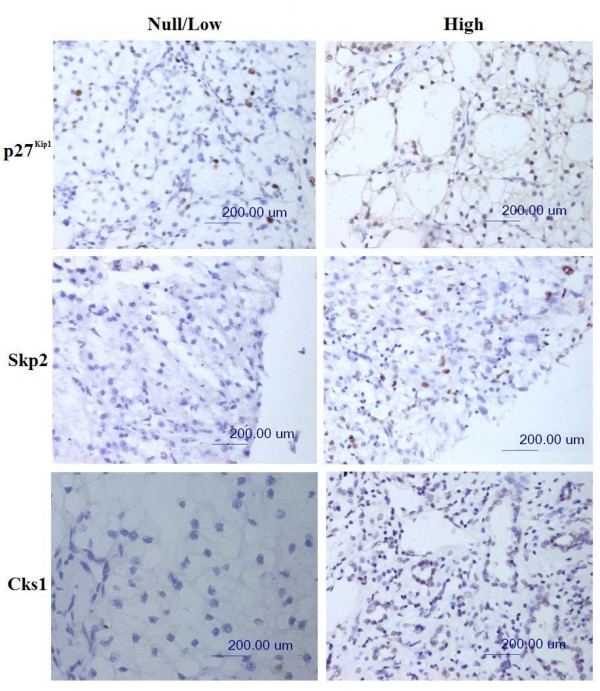
Expression of p27Kip1, Skp2 and Cks1. The proteins showing null/low or high levels of expression with nuclear pattern. (immunohistochemical staining; original magnification ×200; scale bar, 200 μm).